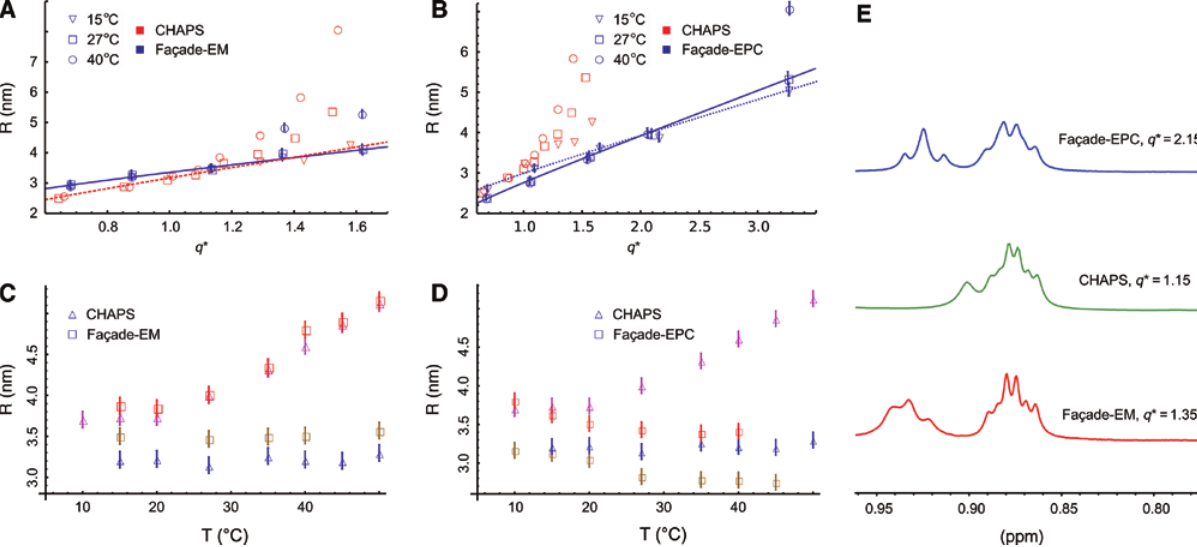
Figure 2: (A) R ( q * ) dependence for the DMPC/CHAPS (red Ref. [25]) and DMPC/Façade-EM (blue) bicelles at 15 (triangles), 27 (squares), and 40 ° C (circles). Fit of the data at 15 ° C to the Eq. (1) is shown by blue solid line for Façade-EM and by dashed red line for CHAPS. (B) R ( q * ) dependence for DMPC/CHAPS (red Ref. [25]) and DMPC/Façade-EPC (blue) bicelles at 15 (triangles), 27 (squares), and 40 ° C (circles). Fit of the data at 15 ° C and 27 ° C to the Eq. (1) are shown by blue dashed and solid lines, respectively. (C, D) R ( T ) dependence is plotted for q * = 1.0 (blue triangles) and q * = 1.28 (magenta triangles) DMPC/CHAPS bicelles [25], q * = 1.15 (C, brown squares) and q * = 1.36 (C, red squares) DMPC/Façade-EM bicelles, q * = 1.1 (D, brown squares) and q * = 1.6 (D, red squares) DMPC/Façade-EPC bicelles. R ( T ) dependencies were measured at almost all q * studied within the current work, and the reported q * were selected as representative for the different kinds of R ( T ) dependencies. (E) Fragments of 1 H NMR spectra of q * = 1.36 DMPC/Façade-EM, q * = 1.15 DMPC/CHAPS, and q * = 2.15 DMPC/Façade-EPC bicelles. Fragments contain the signal of the DMPC methyl group at 0.87 ppm and were recorded at 40 °